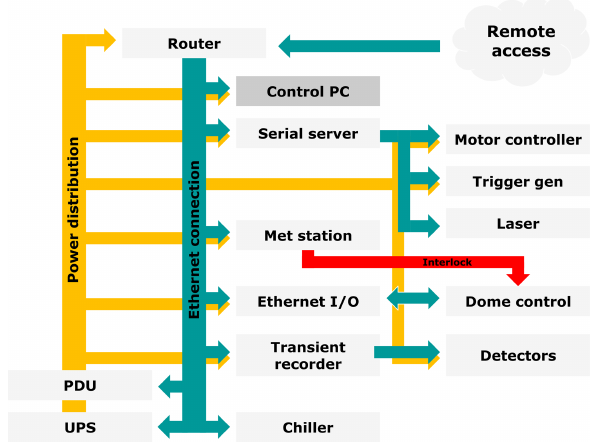
Figure 2. Block diagram describing the power distribution (orange) and data transfer (green) between different subsystems of the lidar. Hatch hardware interlock based on rain sensing is shown in